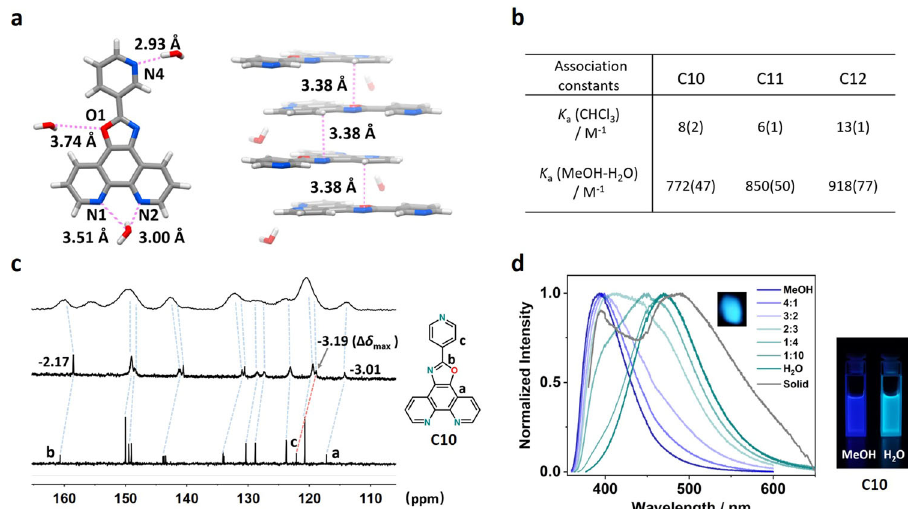
Fig. 3 Physiochemical properties of optimized N/O doping molecules with excellent aqueous solubility. a Crystal structure of C11 (left: hydrogen bonding connecting mode around one C11 molecule, the neighbored N-O distances forming hydrogen bonding were labeled, right: molecular packing along c -axis, the interlayers distances were labeled). b Apparent association constants for C10 - C12 in CHCl 1 H NMR fi tting, 3 and H 2 O were estimated via respectively. c Comparison of 13 C NMR spectra for C10 in different existing states (bottom: MeOD- d 4 , middle: D 2 O, up: solid-state 13 C MAS). d Left: luminescent emission spectra of C10 upon 365 nm excitation in solution with viable solvent ratios and solid states (inserted is the photograph of the solid sample when excitation), right: photograph of C10 emission upon 365 nm excitation in MeOH and H 2 O,